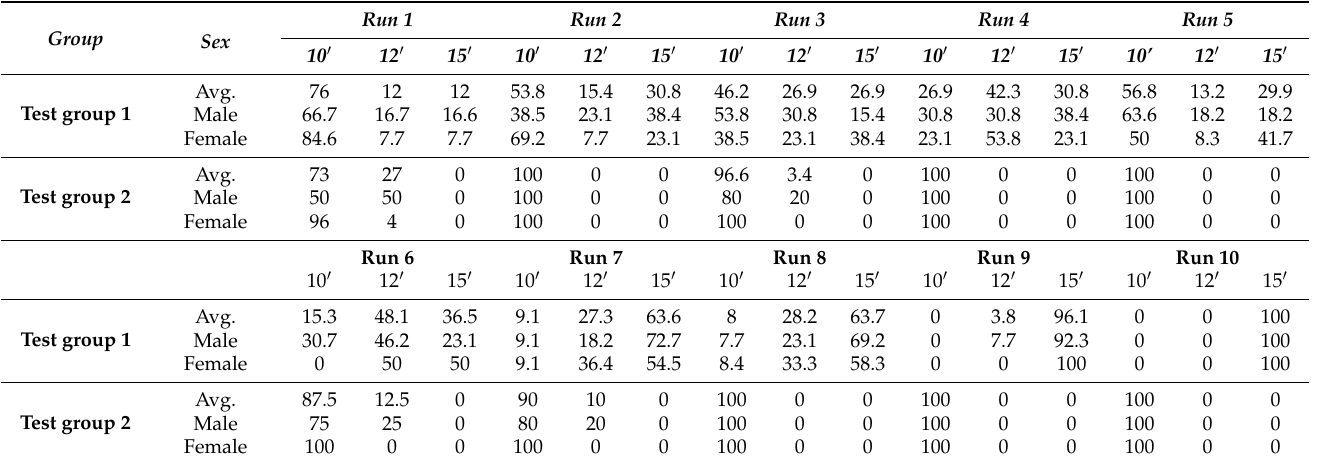
Table 3. The percentage-based distribution of the selected times.